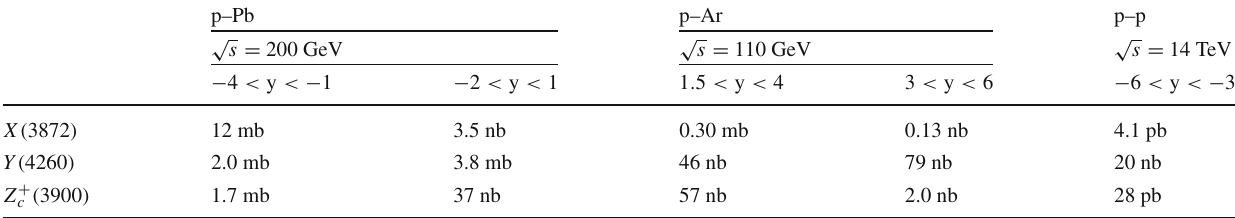
of pPb and pAr UPCs are performed in low energy models while the predictions in large rapidities are employed in high energy models. The predictions of pp UPCs are adopted in high energy models